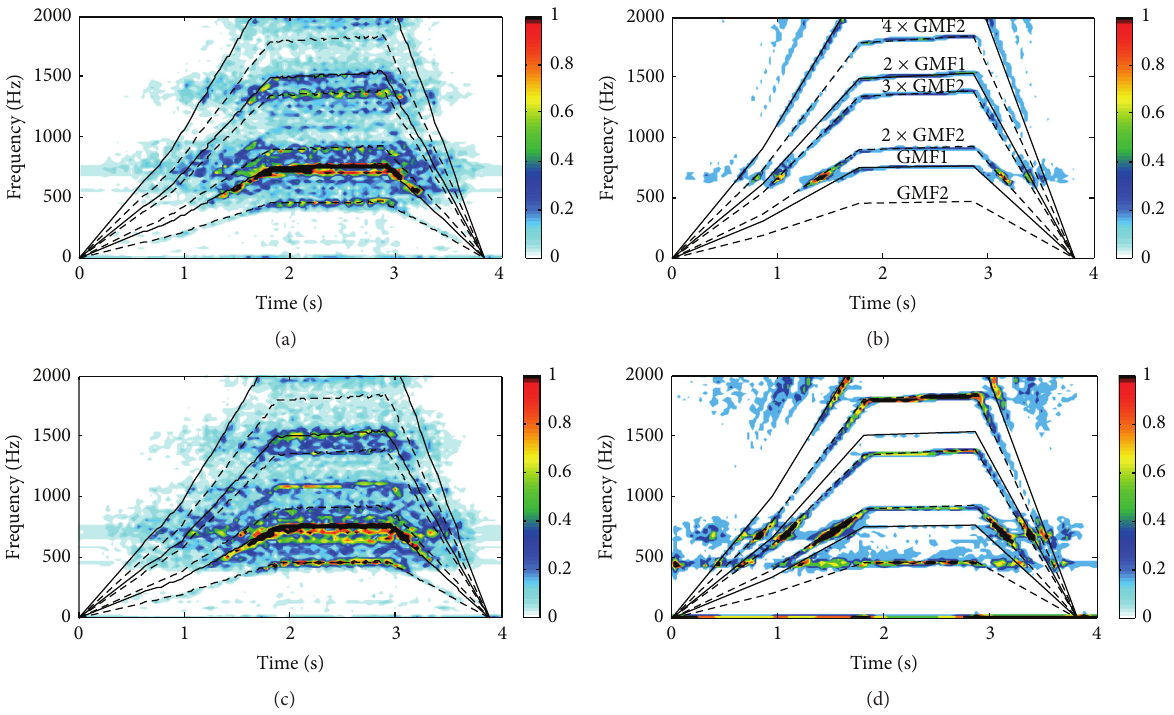
Figure 10: HWT of experimental data and model results for varying speed test: (a) healthy data, (b) healthy model, (c) damaged (missing tooth) data, and (d) damaged model, with gear mesh frequencies (GMF) and integer harmonics